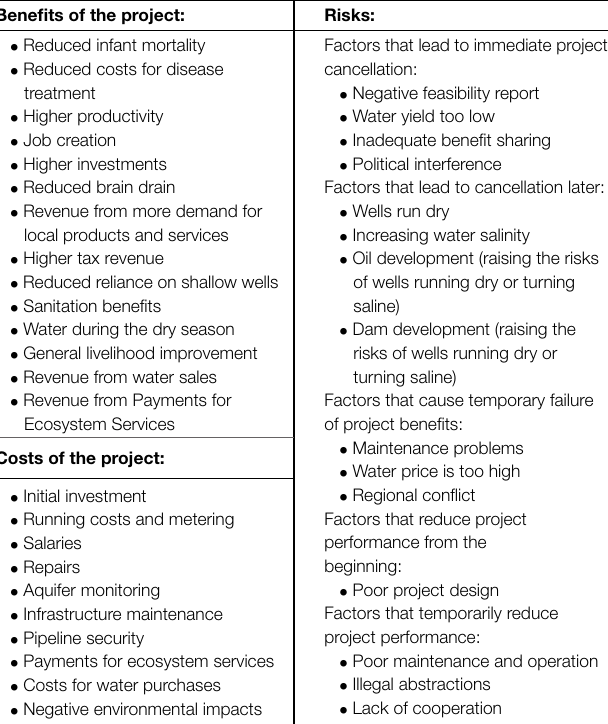
TABLE 1 | Relevant benefits, costs and risks of the pipeline project, as identified by members of the modeling